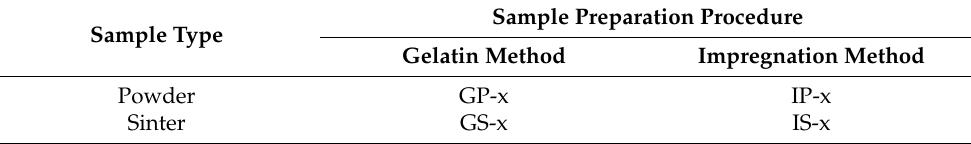
Table 1. Sample designation (x—alumina content